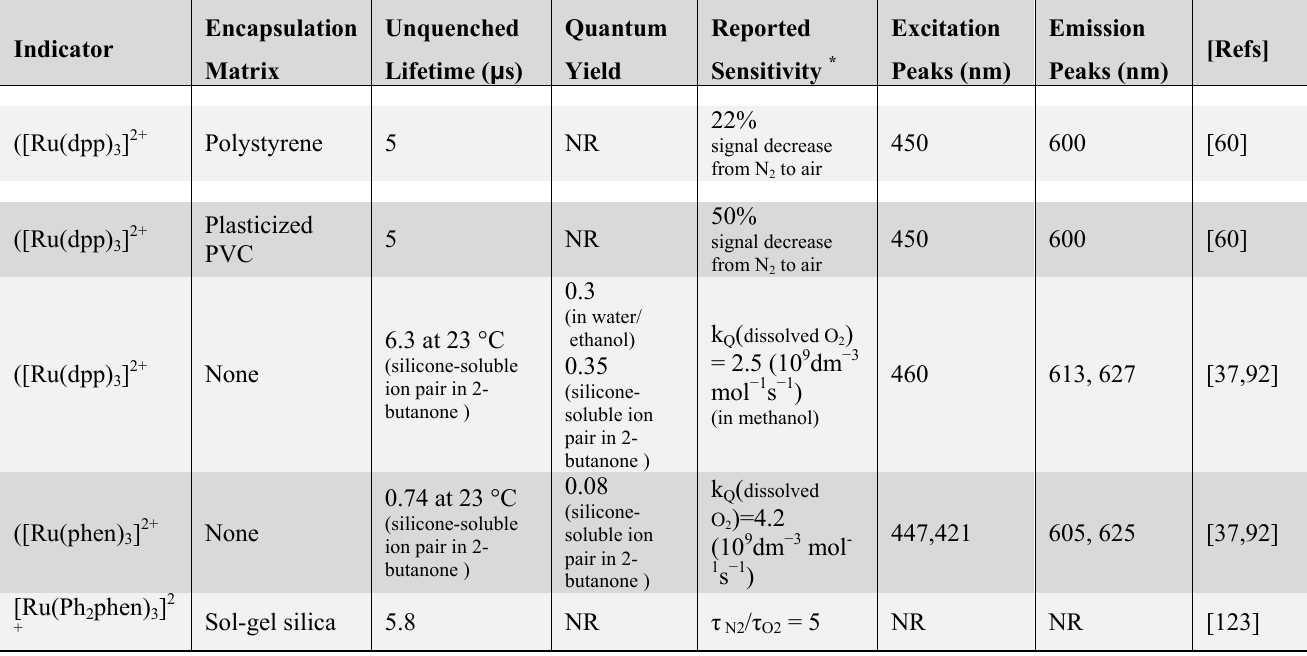
Table 1. Properties of indicator materials in various encapsulation matrices as previously reported.